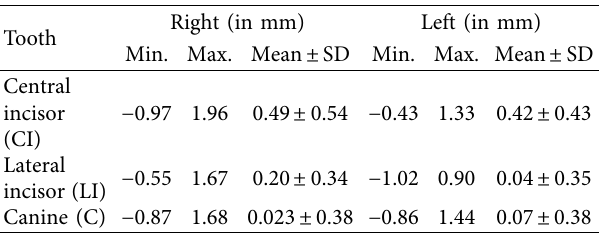
Figure 2: Distribution of the study population according to ethnicity. Table 1: GZP of upper anterior teeth with respect to VBM of each